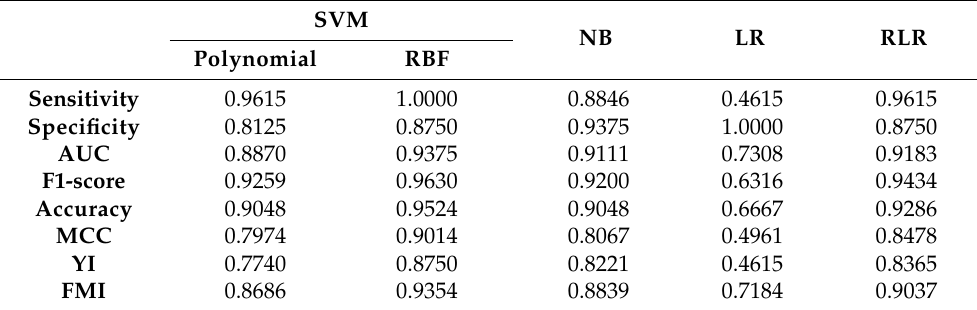
Table 4. Performance comparison of ADASYN-based SVM with different kernel functions, NB, LR, and